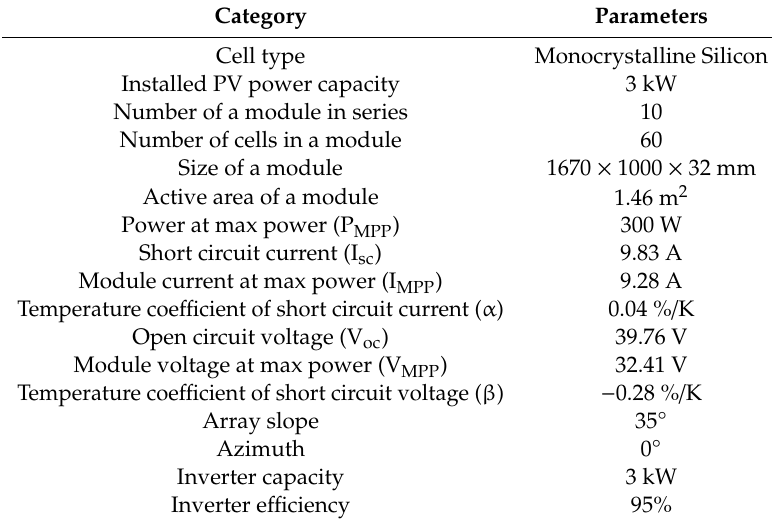
Table 6. Specifications of the PV